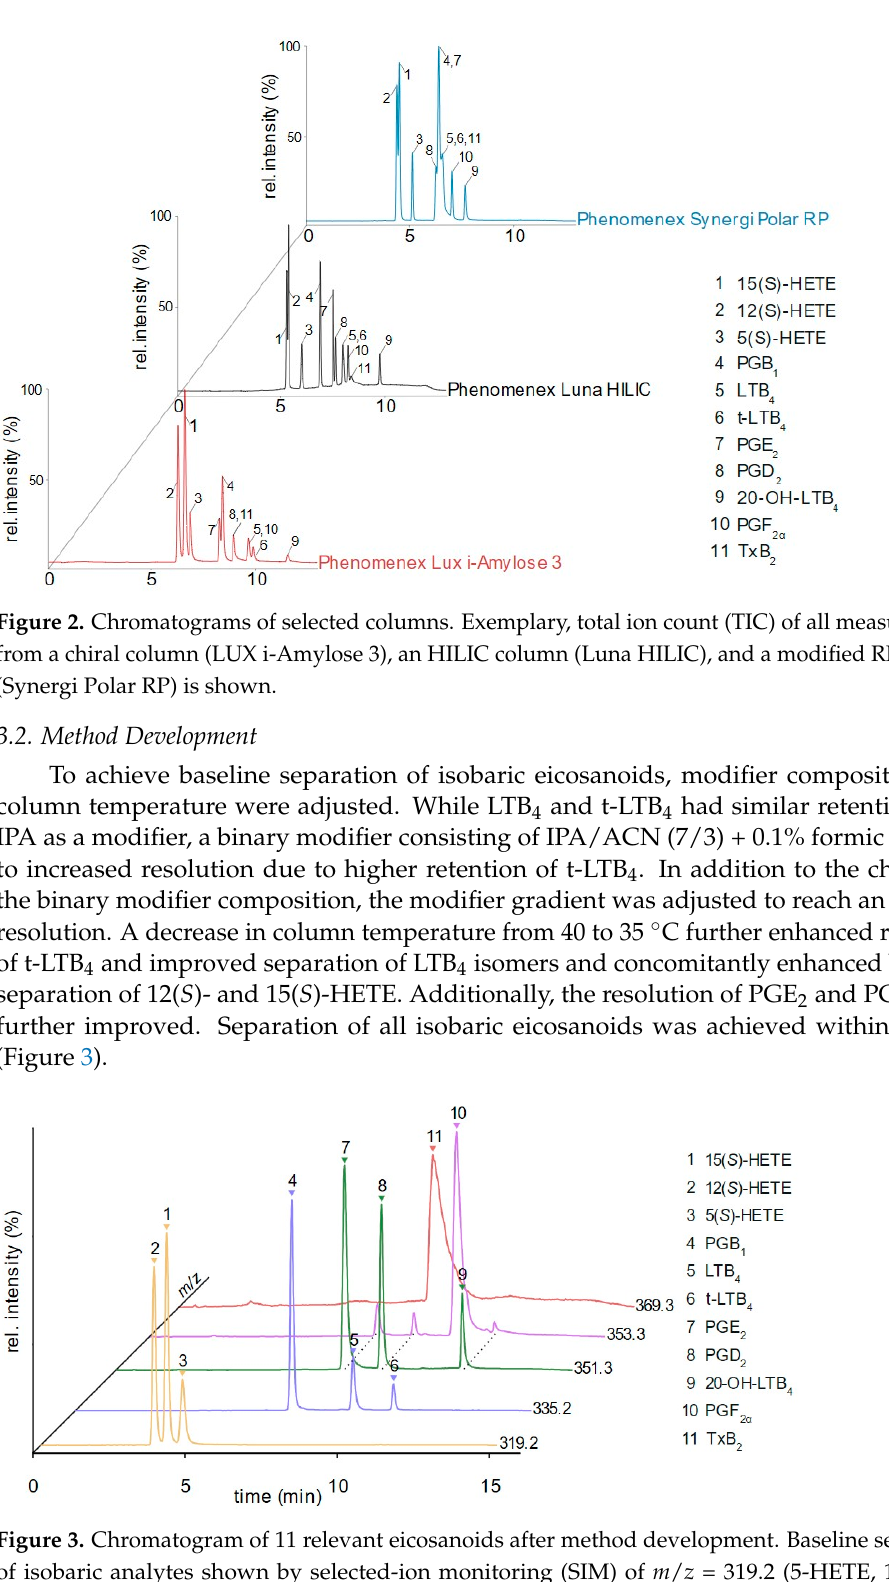
Table 1. Capacity factors of eicosanoids included in the method and their corresponding m/z values for detection by mass spectrometry. Compound